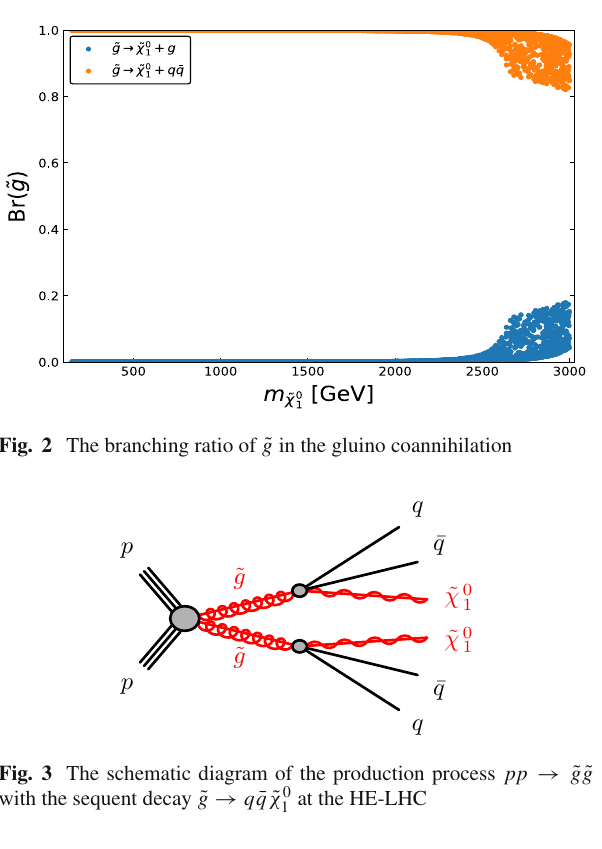
at the HE-LHC 1